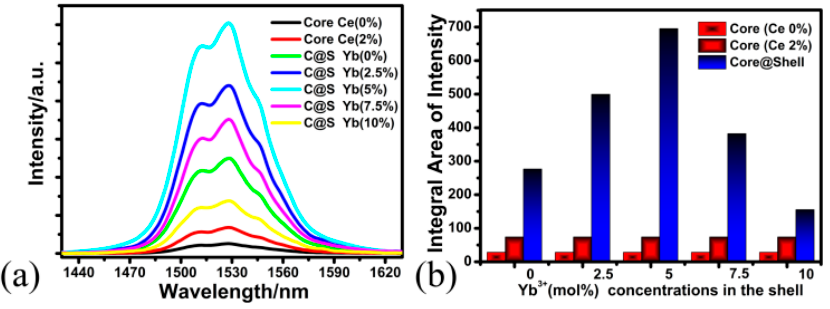
Figure 5. ( a ) DC emission spectra of BaLuF 5 :18%Yb 3+ ,2%Er 3+ core NPs, BaLuF 5 :18%Yb 3+ ,2%Er 3+ ,2%Ce 3+ core NPs and BaLuF 5 :18%Yb 3+ ,2%Er 3+ ,2%Ce 3+ @BaLuF 5 : x %Yb 3+ NPs ( x = 0, 2.5, 5, 7.5 and 10) core-active-shell NPs under the excitation of a 980 nm laser diode. ( b ) Intensity enhancement of DC emission depending on the Yb 3+ concentrations in BaLuF 5 core-active-shell NPs.